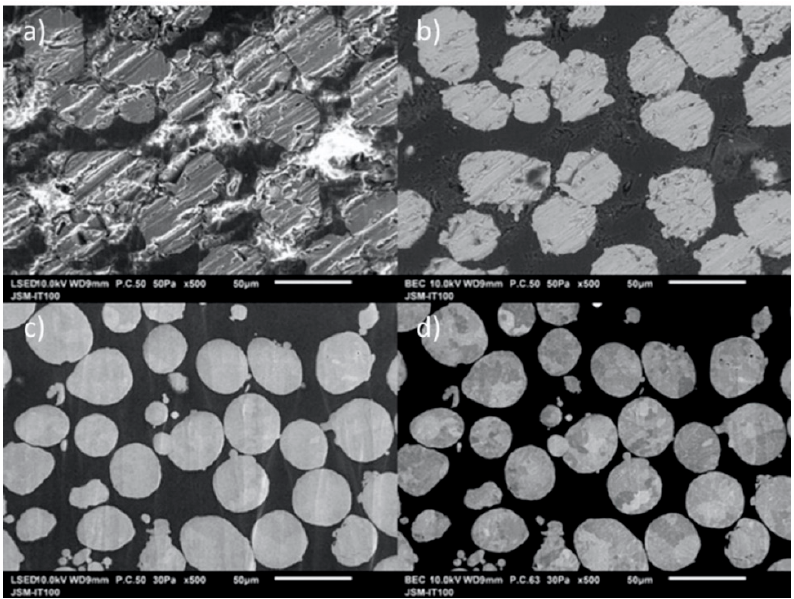
Figure 8. SEM micrographs of Al 6061 powder during and after cross-sectional argon ion beam polishing is presented herein: ( a , b ) depict secondary electron and backscatter electron SEM micrographs before achieving the final polish, respectively; ( c , d ) capture similar micrographs after polishing.